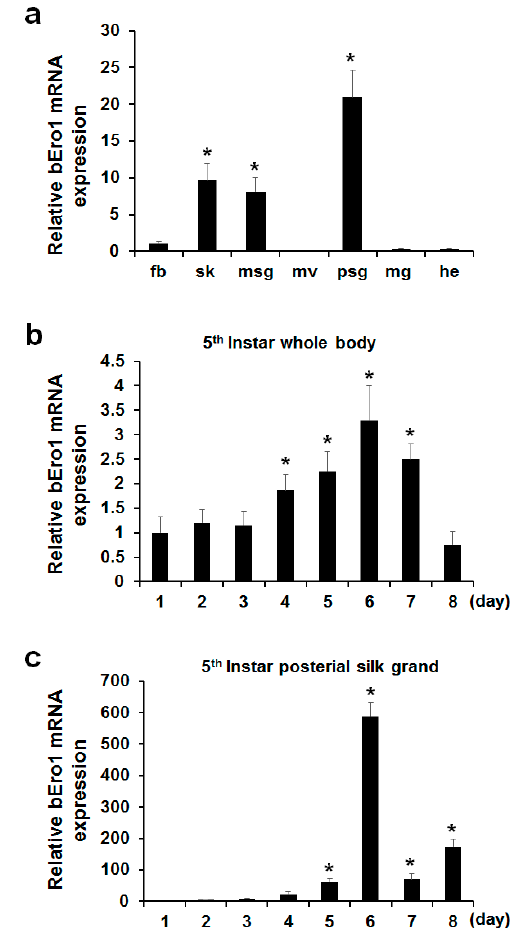
Figure 2. Expression of bEro1 in various tissues, developmental stages of 5th instar whole body, and posterial silk grand of B. mori. ( a ) Expression levels of bEro1 in various tissues, including fat body (fb), skin (sk), middle silk grand (msg), malpighian vessels (mv), posterial silk grand (psg), midgut (mg) and head (he) in 5th instar three-day larvae. Relative expression levels are presented as the mean ±SD ( n = 6); * p < 0.05 versus fat body. Total RNA was extracted from 5th instar (1–8 days) larvae from whole body ( b ) and posterial silk grand ( c ). Relative expression levels are presented as the mean ± SD ( n = 6); * p < 0.05 versus day one.